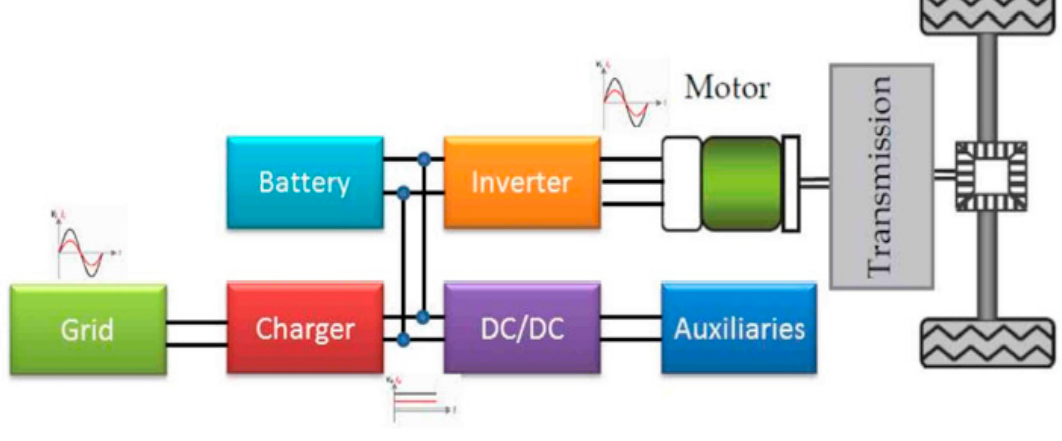
Figure 1. Electric car power train scheme [6].